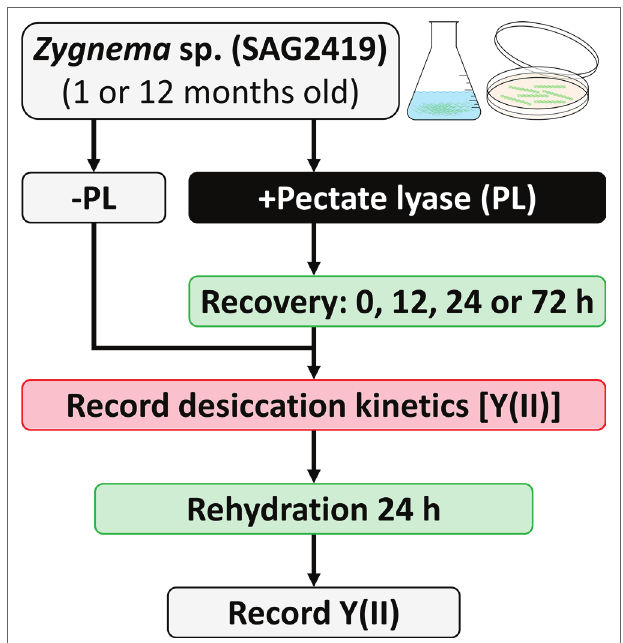
FIGURE 1 | Experimental setup for enzymatic homogalacturonan removal and measuring the photosynthetic performance in response to desiccation treatment. Algal filaments are desiccated on glass fiber filters in a desiccation